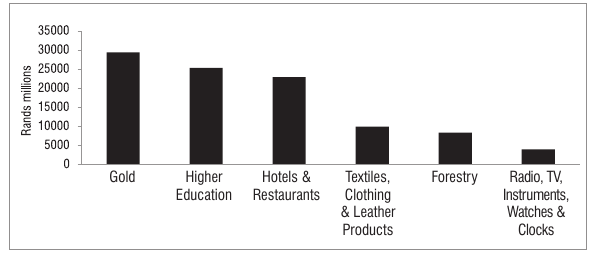
Value-added selected sectors for South Africa in 2009 (current